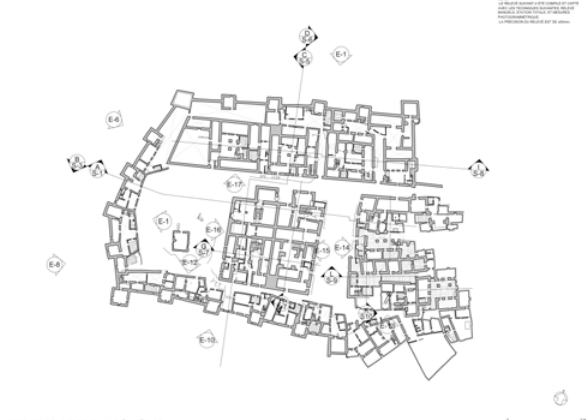
Figure 6: CAD floor plan, with integration of different survey